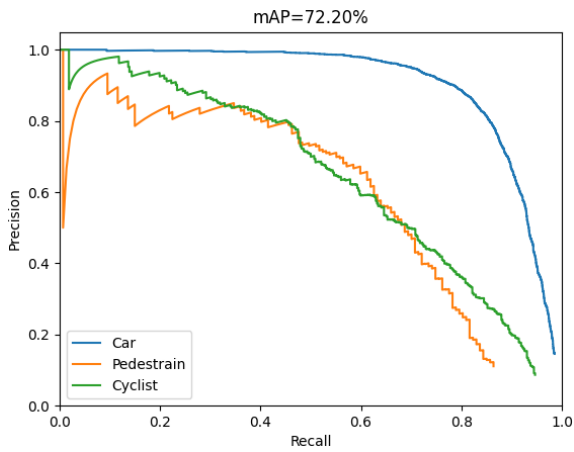
Figure 10. The mAP of the Model 4 in the KITTI dataset.